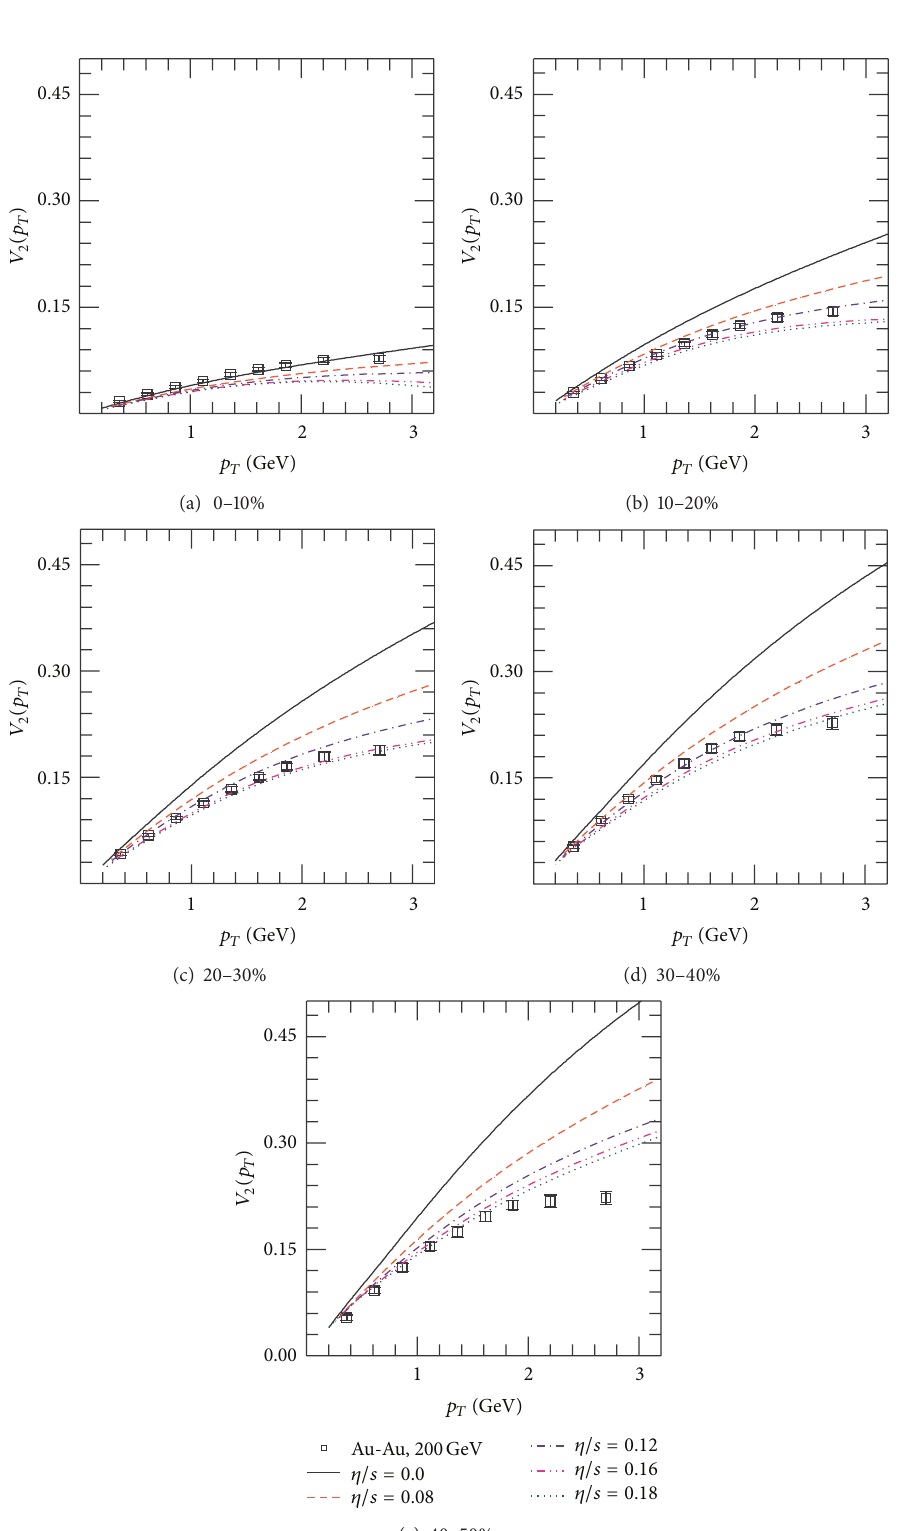
Figure 10: Same as in Figure 9 but for elliptic flow. The figures are from